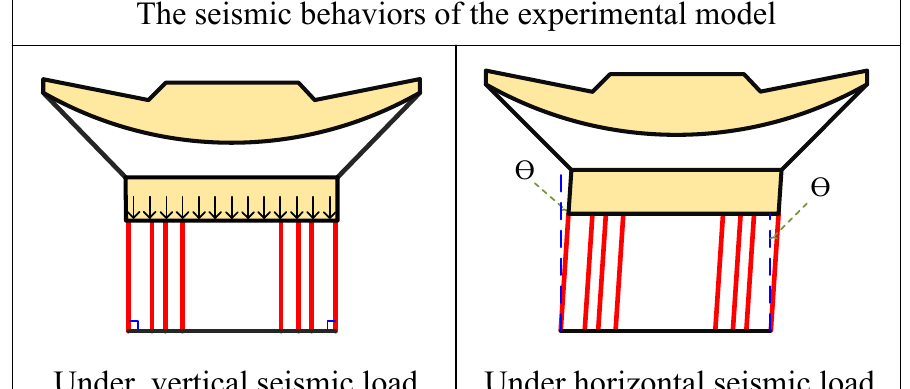
Figure 13. Flexibility of the wooden structure.